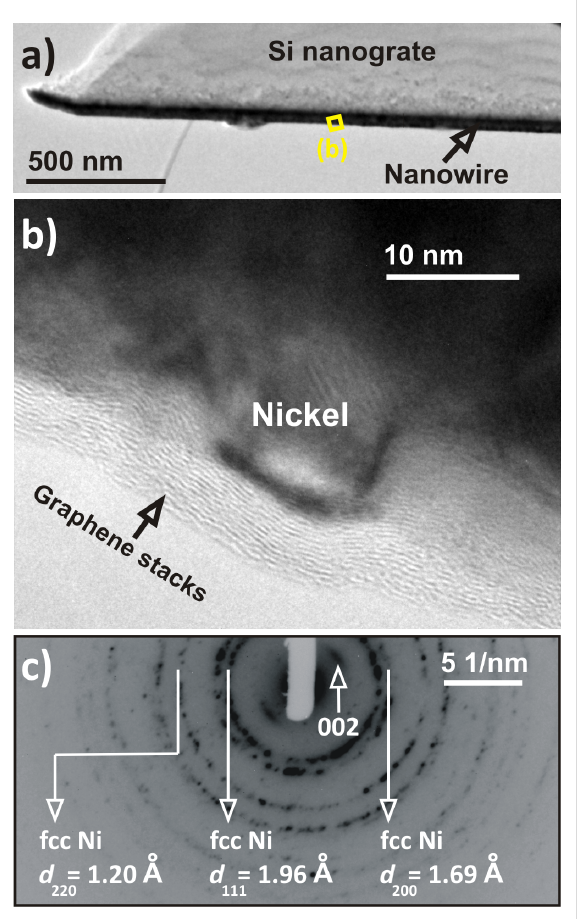
Figure 3: (a) TEM micrograph of a coaxial nanowire as prepared on a silicon nanograted structure. (b) High-resolution TEM micrograph showing the presence of several stacked graphene layers wrapping the nickel nanowire. (c) Selected-area electron diffraction pattern recorded on a single wire. The 002 reflection indicated in (c) is attrib- uted to graphitic carbon.